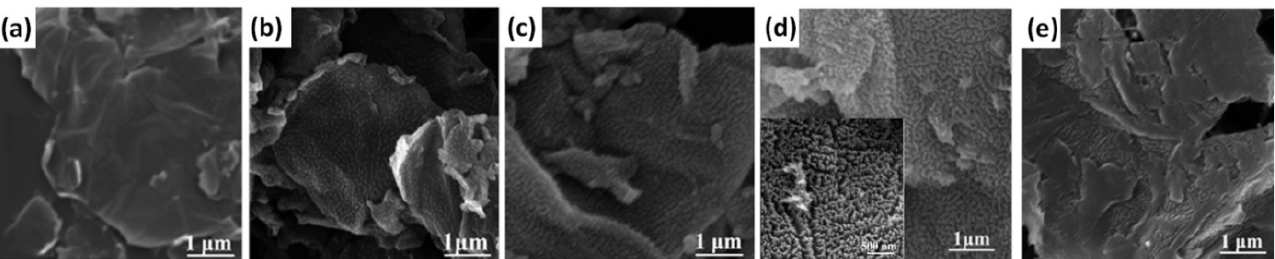
Figure 9. SEM images of PANI-RGO obtained at different reaction intervals: 1 h ( a ), 1.5 h ( b ), 2 h ( c ), 3 h (inset: high magnification SEM image) ( d ), 6 h ( e ) [55].